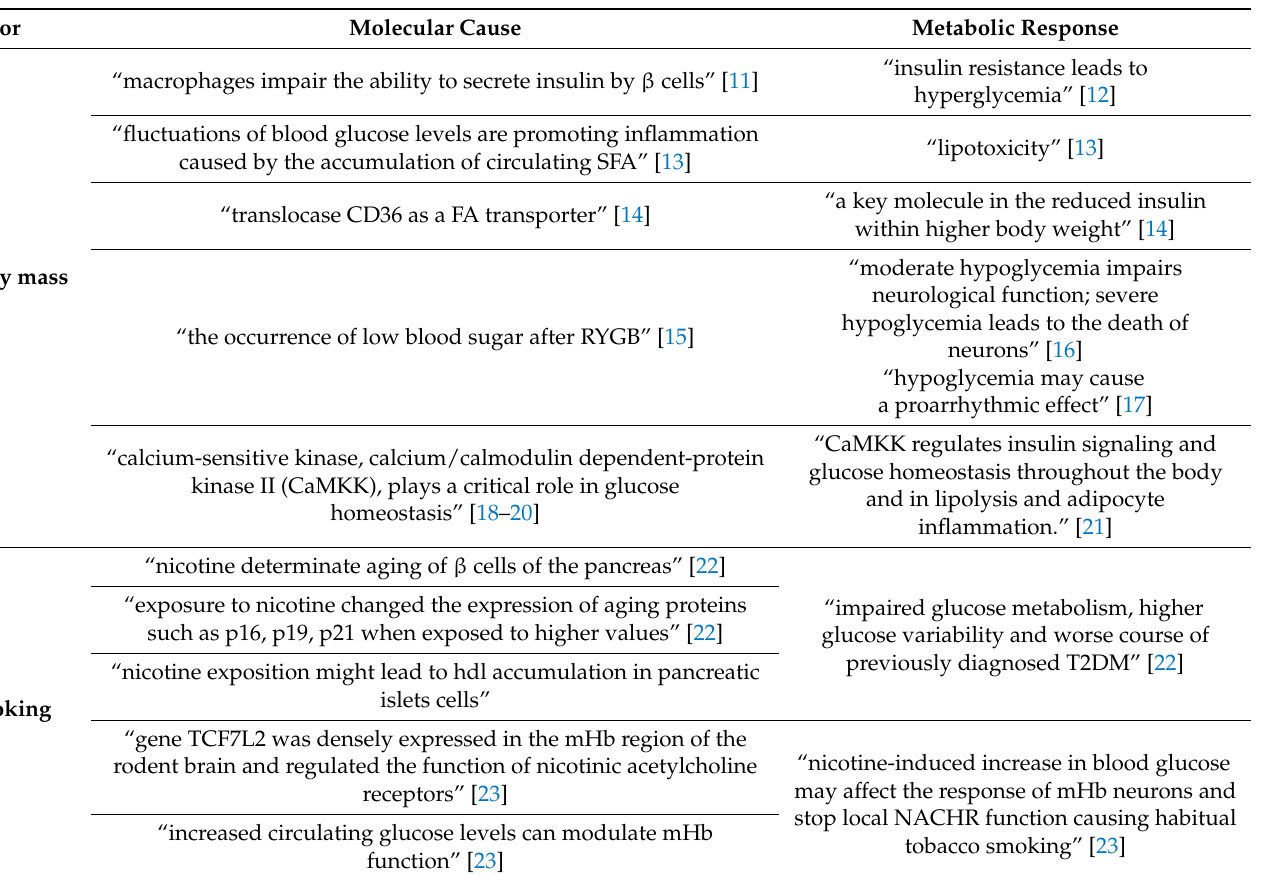
Table 1. The molecular consequences of factors affecting glucose